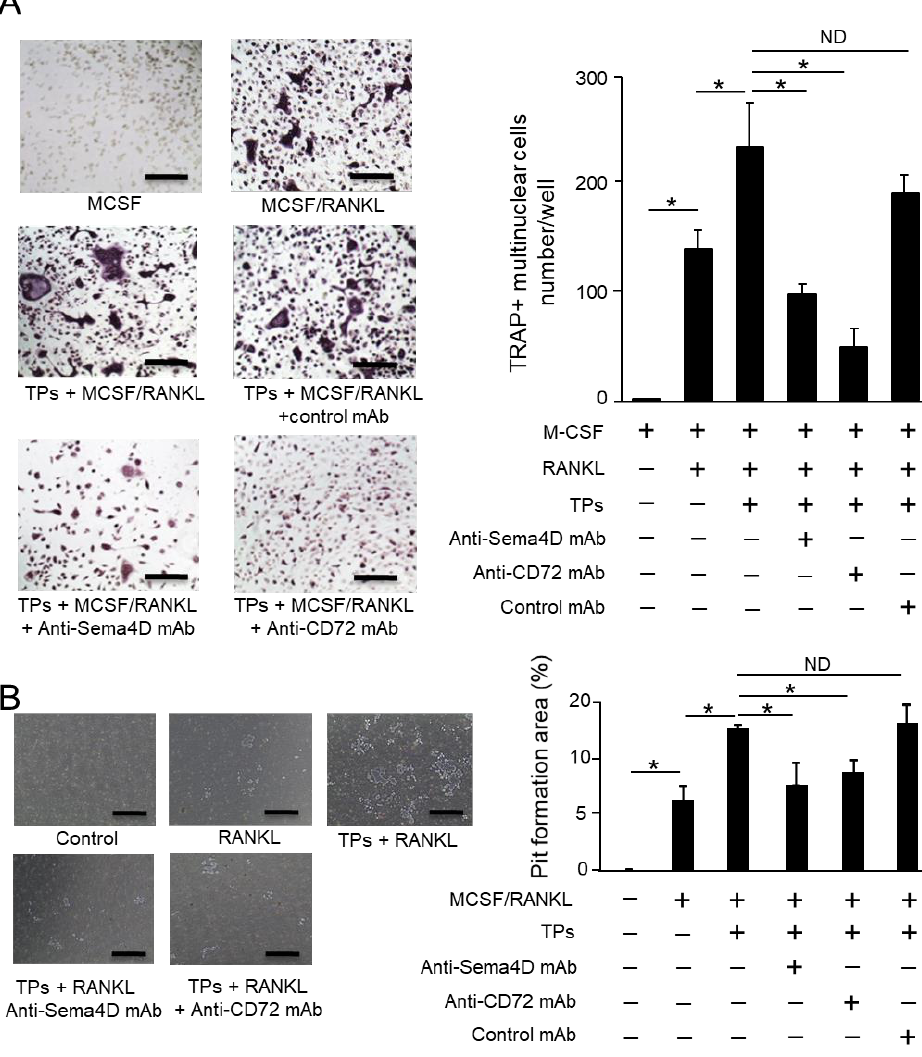
Figure 5. The effect of anti-Sema4D mAb and anti-CD72mAb on RANKL-dependent osteoclastogenesis. BMMCs were cultured in osteoclastogenic medium and TPs (1 × 10 4 cells) with or without anti-Sema4D mAb, anti-Cd72 mAb or control mAb. The number of TRAP-positive multinuclear cells (over three nuclei) was counted ( A ), and pit formation area was evaluated ( B ). Data represent the mean ± SD of three independent experiments. Values are mean ± S.D. * p < 0.01. ND: No statistically significant difference. Bar = 50 µm. +: Applied. − : Not applied.